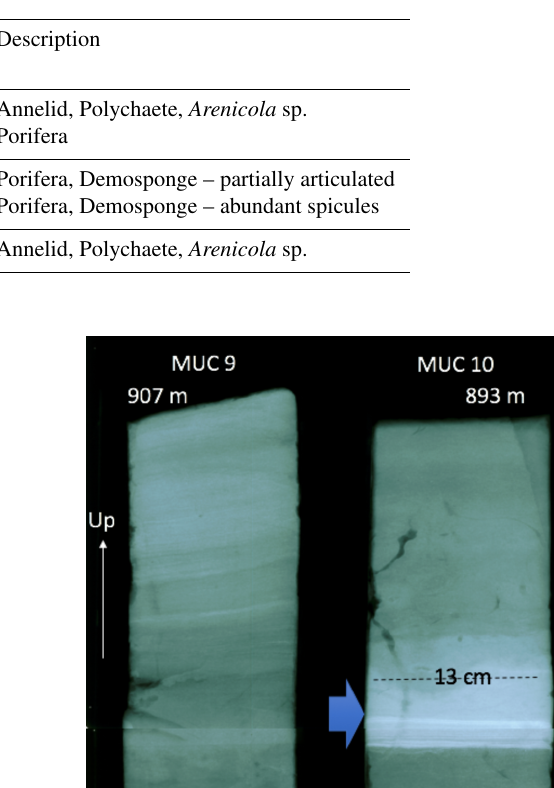
Table 1. Macrofauna for selected SMB 2016 MUC cores.